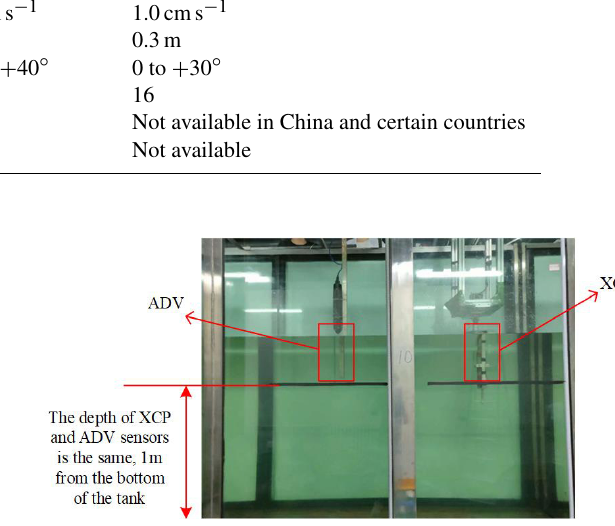
Figure 17. Photograph of the ADV and XCP comparison experi-